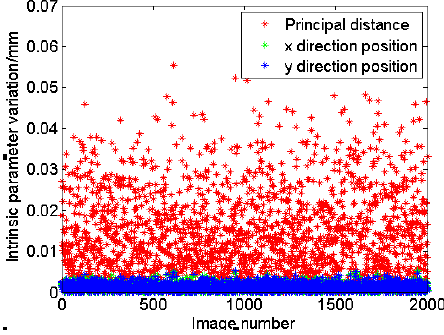
Figure 17. Calibration precision testing.